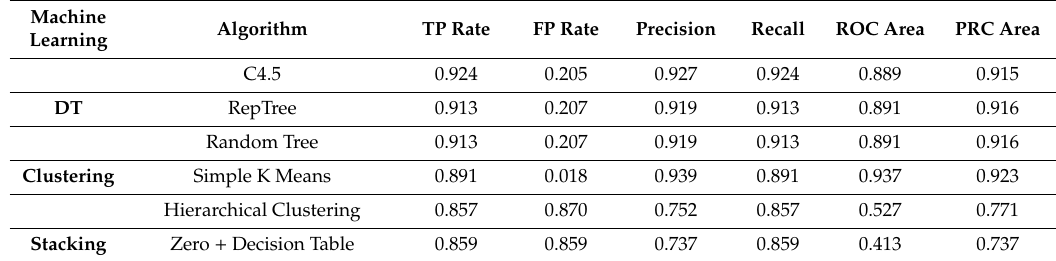
Table 3. DT evaluation. FP: false positive; PRC Area: area under the precision–recall curve; ROC Area: area under the receiver operating characteristic curve; TP: true